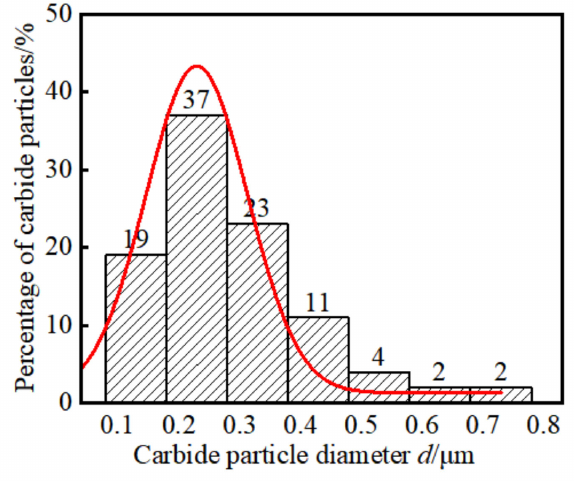
Figure 7. The undissolved carbide diameter distribution after isothermal process for 6 h at 230 ◦ C.